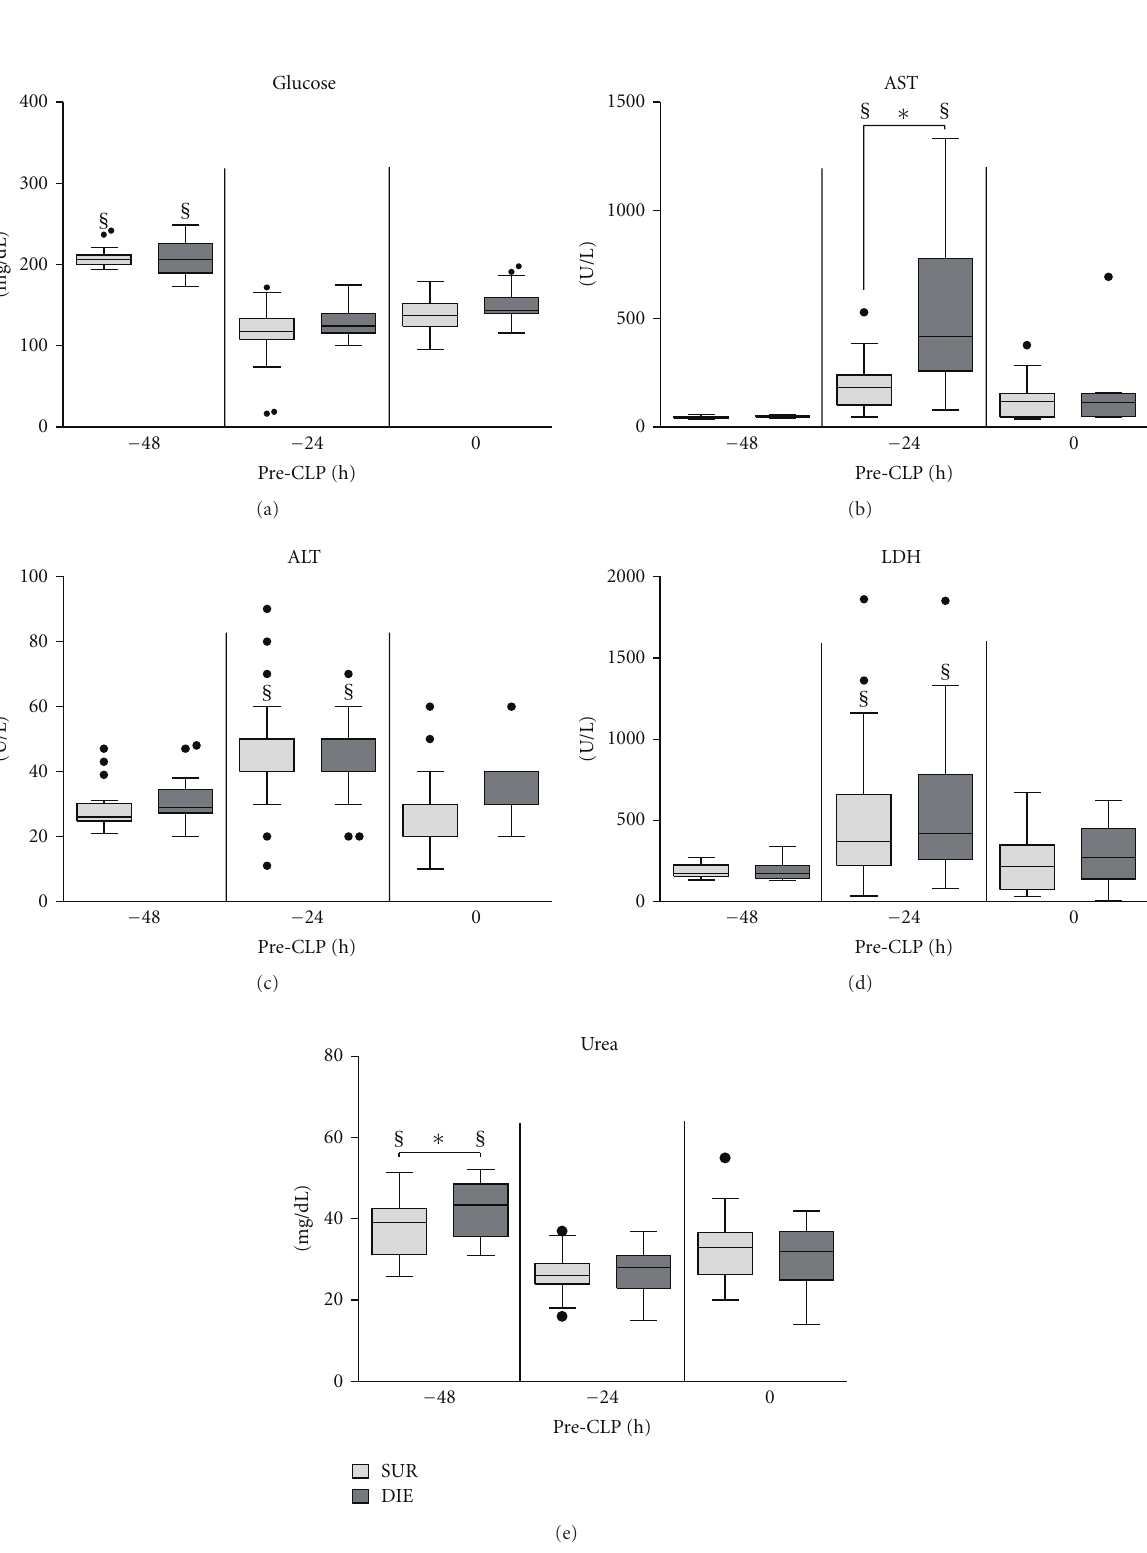
Figure 5: Retrospective comparison of circulating glucose, AST, ALT, LDH, and urea in dying (DIE) versus surviving (SUR) animals prior to CLP. 3-month-old female mice were subjected to trauma/hemorrhage prior to CLP. Displayed values were compared between DIE and SUR at − 48 h (DIE n = 16, SUR n = 18; AST: DIE n = 6, SUR n = 12), − 24 h (DIE n = 23, SUR n = 32; AST: SUR n = 21), 0h before-CLP (DIE n = 23, SUR n = 32; AST: DIE n = 8, SUR n = 21) and between time points. § P < . 05 between time points, and ∗ P < . 05 between DIE and